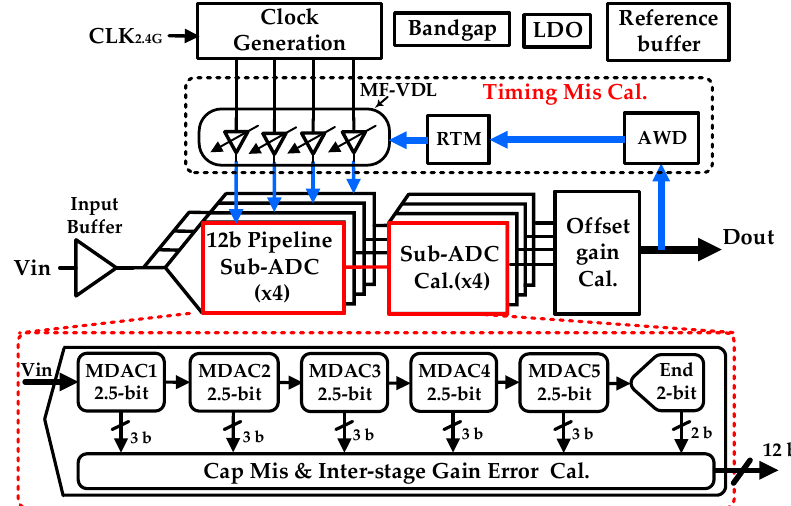
Figure 8. Top-level architecture of the proposed 2.4GS/s 12bit ADC.